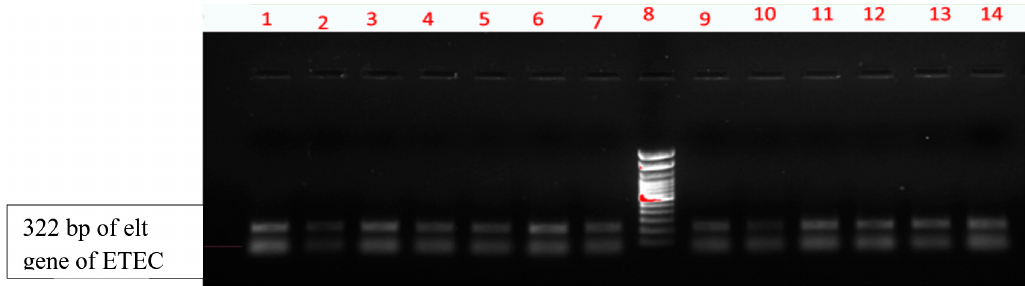
Fig. 3. Lane: 1-7 and 9-14(13samples) contains elt gene of 322bp of ETEC gene and Lane 8: Ladder (100bp-1000bp)